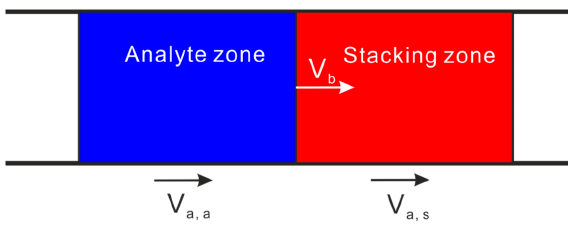
Figure 1. Schematics of the stacking mechanism via manipulation of the net velocities of analytes. The analyte in the analyte (stacking) zone moves with a velocity of V a,a ( V a,s ), and the boundary between analyte zone and stacking zone moves with a velocity of V b .